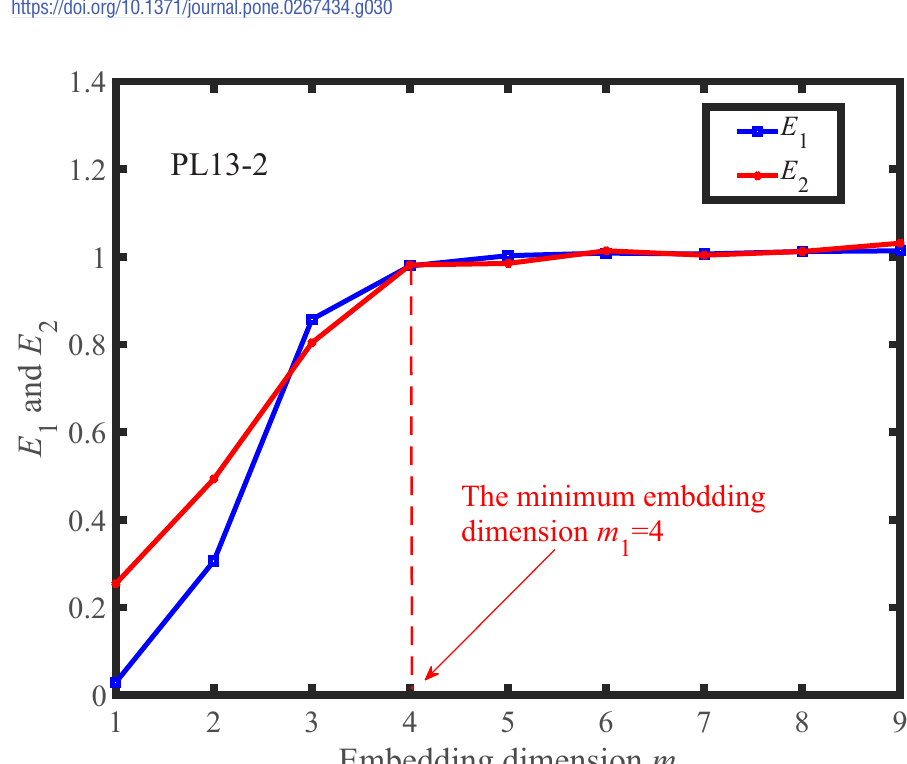
Fig 31. E 1 ( m )~ m and E 2 ( m )~ m curves for the observed displacement data series of the